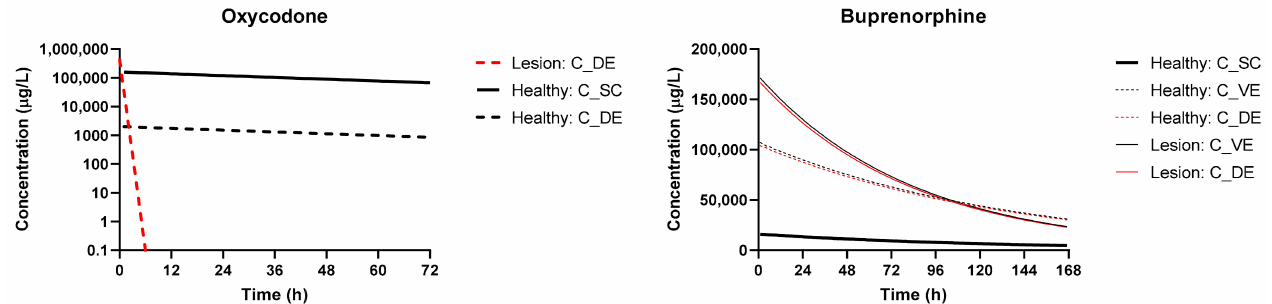
Figure 5. Prediction of skin layer concentrations for compounds administered in healthy patients and patients with lesions. The Oxycodone dataset excludes Viable Epidermis (VE) concentration plots, as the high permeability of that layer results in a concentration profile that is virtually identical to the concentration at apical dermis